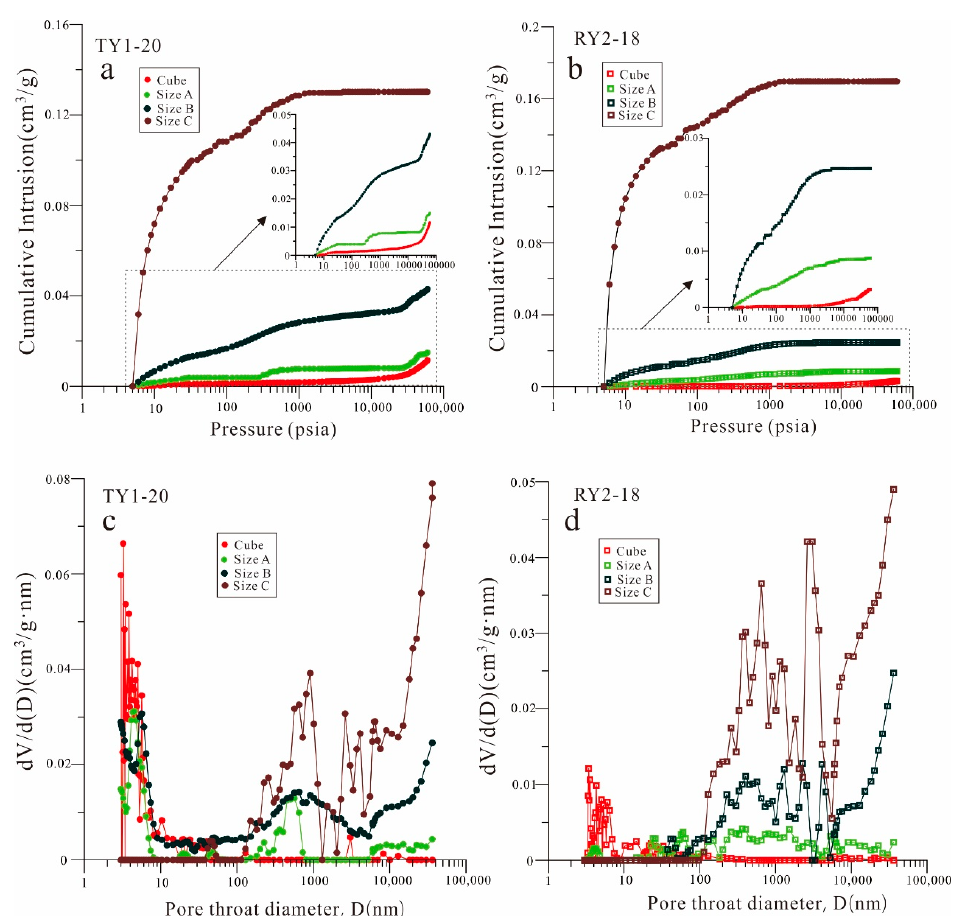
Figure 7. ( a , b ) MICP intrusion curves and ( c , d ) pore volume distribution vs. pore-throat diameters for the TY1-20 and RY2-18 samples with four different sample sizes. Energies 2020 , 13 , x FOR PEER REVIEW 14 of 23